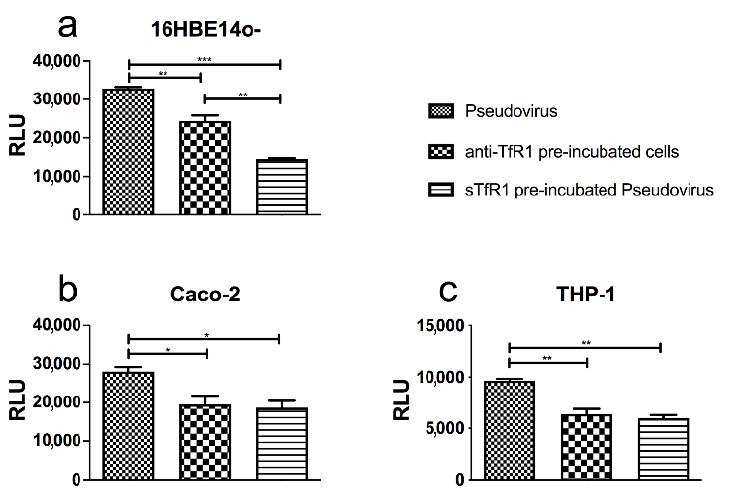
Figure 6. Luminescence of Pseudovirus observed in in 16HBE14o- ( a ), Caco-2 ( b ) and THP-1 ( c ) cells infected at multiplicity of infection (MOI) of 10 in the presence or absence of 200 nM monoclonal antibody recognizing the ectodomains of human transferrin receptor 1 (TfR1) (anti-TfR1) or 200 nM soluble human TfR1 (sTfR1). See text for details. Data represent the mean values of three independent experiments. Error bars: standard error of the mean. Statistical significance is indicated as follows: *: p < 0.05; **: p < 0.01; ***: p < 0.001 (one-way ANOVA with post-hoc Tukey test). RLU = Relative Luminescence